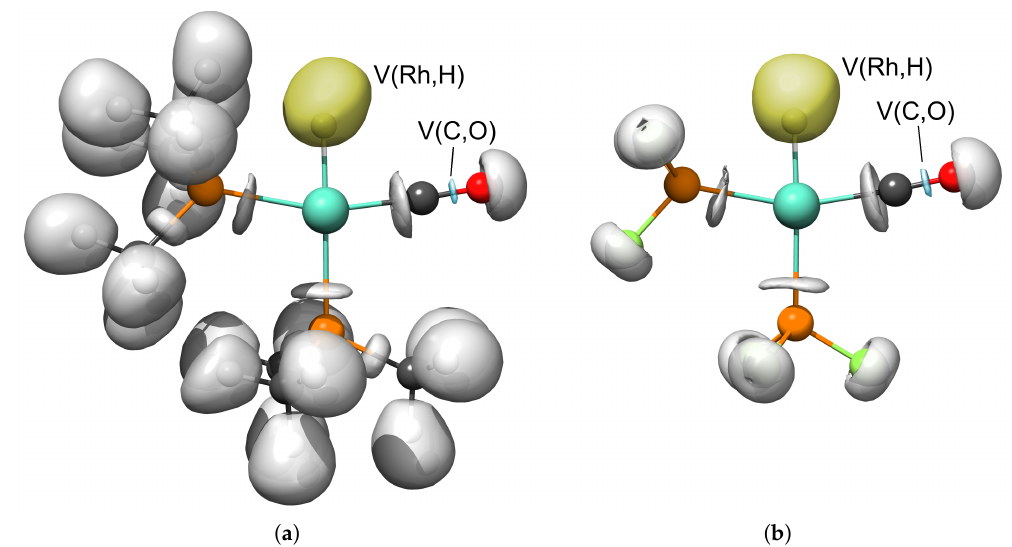
Figure 5. Selected electron localization function (ELF) valence basins for complexes HRh(PMe 3 ) 2 (CO) ( a ) and HRh(PF 3 ) 2 (CO) ( b ) at isovalue of η = 0.84. Yellow and blue envelopes designate the disynaptic V(Rh,H) and V(C,O) basins,